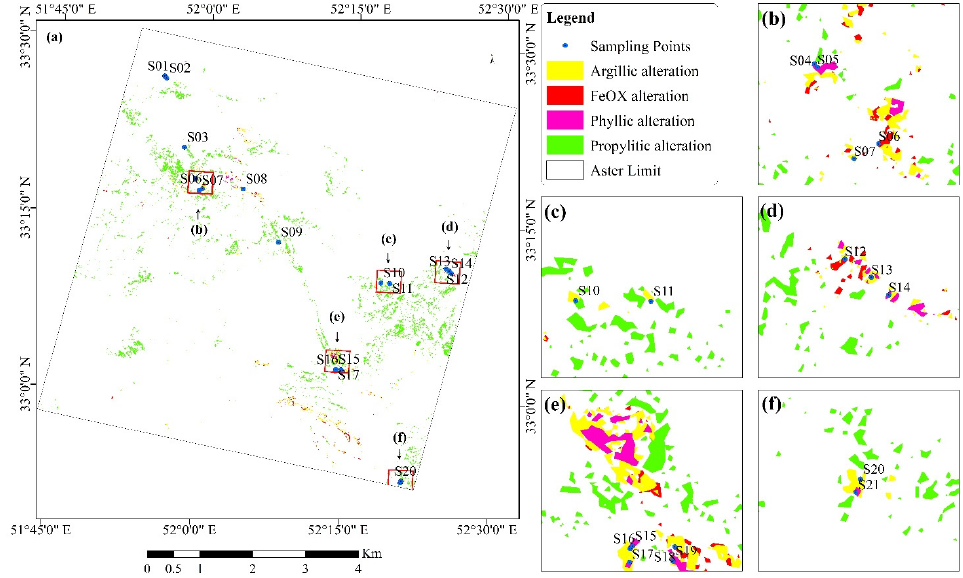
Figure 9. The results of SVM spectral mapping on the ASTER data. ( a ) ASTER full scene of the study area. ( b–f ) Selected subsets for sampling and field survey.